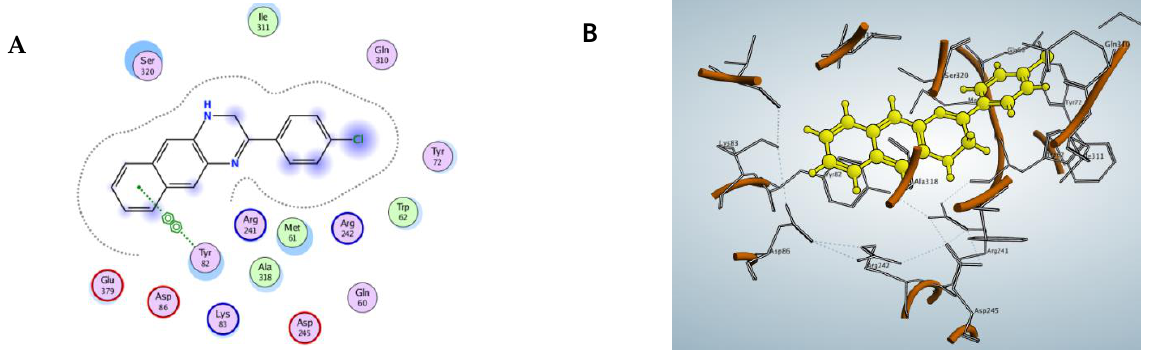
Figure 7. ( A ) 2D binding mode of compound 3 docking in the active site of topoisomerase II (PDB entry: 1ZXM), illustrating one π–π interaction with Tyr 82, hydrogen atoms were omitted for clarity. ( B ) 3D binding mode of compound 3 (rendered in balls and stick mode and colored by yellow) in the active site of topoisomerase II (PDB entry: 1ZXM), hydrogen atoms were omitted for clarity.